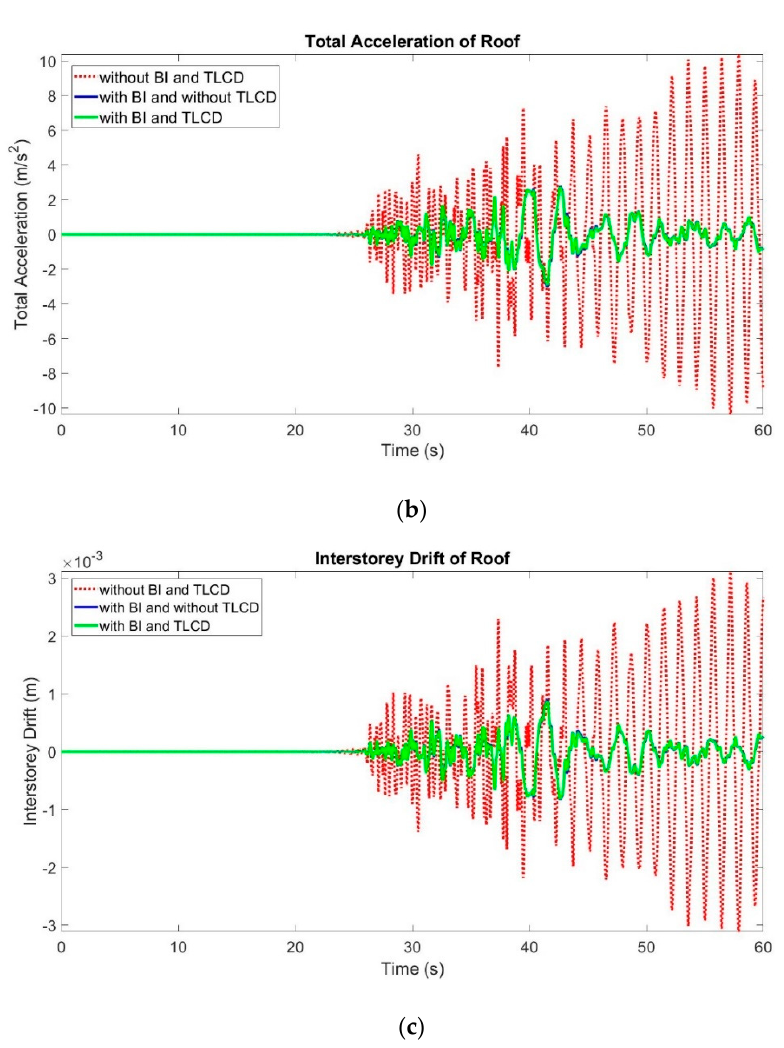
Figure 6. Response time histories of the roof level for the earthquake-prone simple uncontrolled structure, base-isolated structure, and hybrid-controlled structure no. 37 record: ( a ) displacement; ( b ) total acceleration; ( c ) interstory drift.